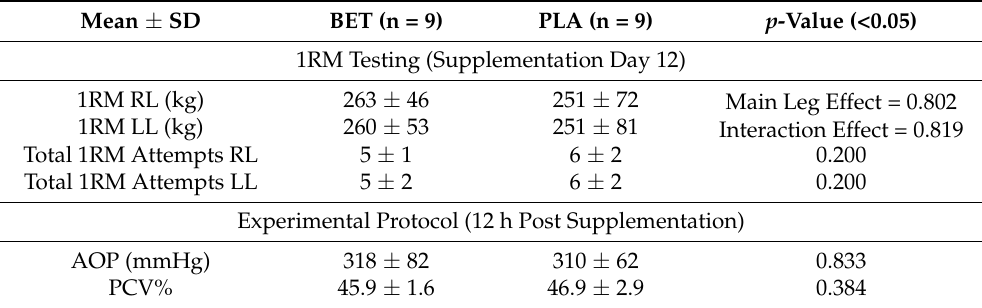
Table 2. Second (1RM assessment) and third (experimental protocol/final) visit hematocrit/packed